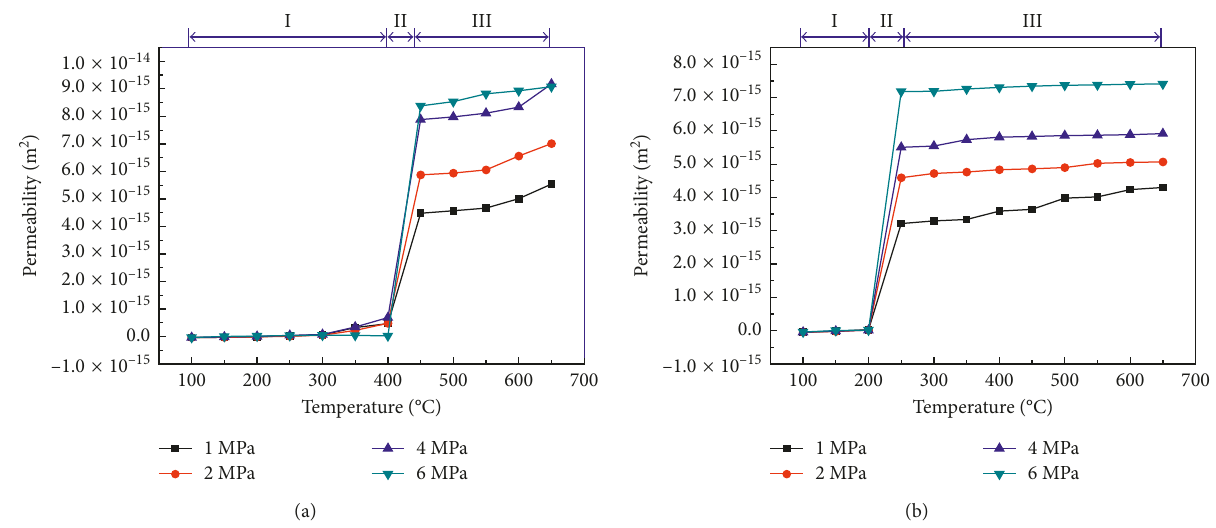
Figure 6: The permeability variation rule of granite specimen with the high initial damage. (a) The permeability of granite specimen with initial axial compression at 80% of UCS. (b) The permeability of granite specimen with initial axial compression at 90% of